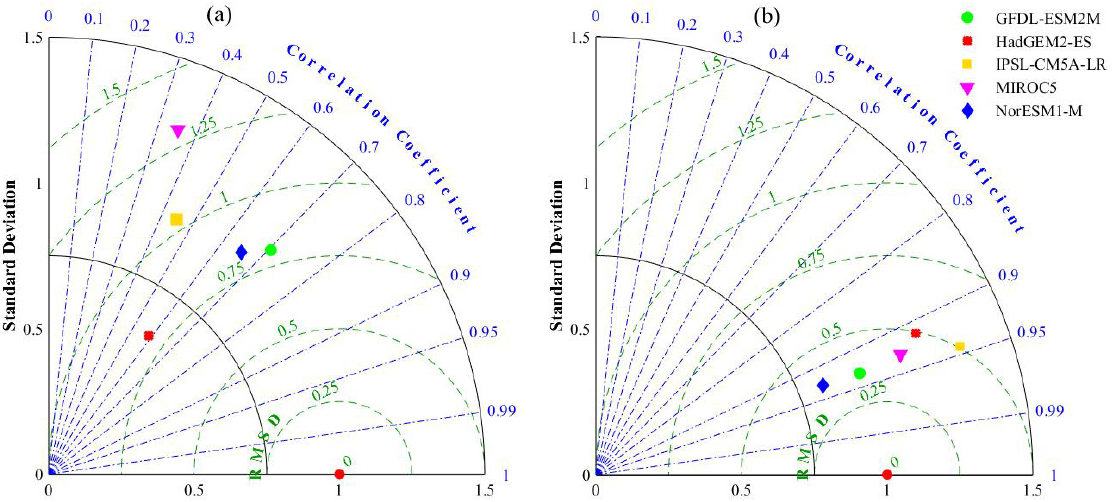
Figure 4. Taylor diagrams of different parameterization schemes under the RCP2.6 climate scenario: ( a ) precipitation and ( b ) mean temperature from 2007 to 2015.